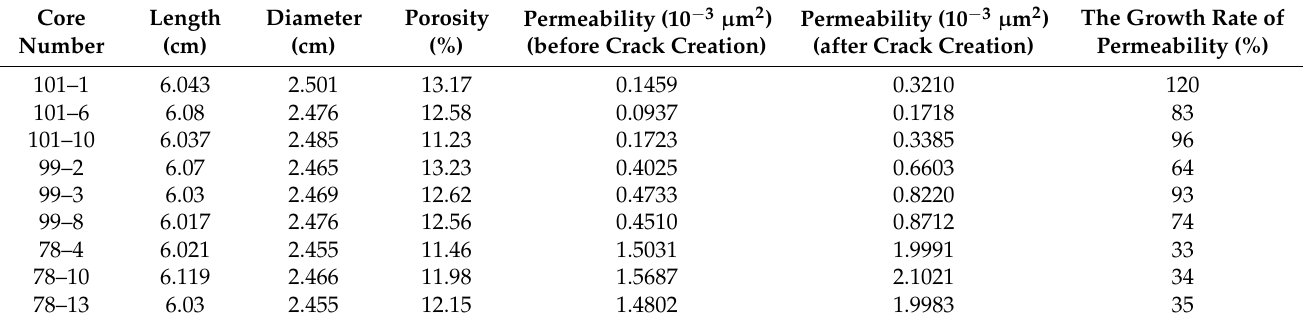
Table 2. Basic data of the